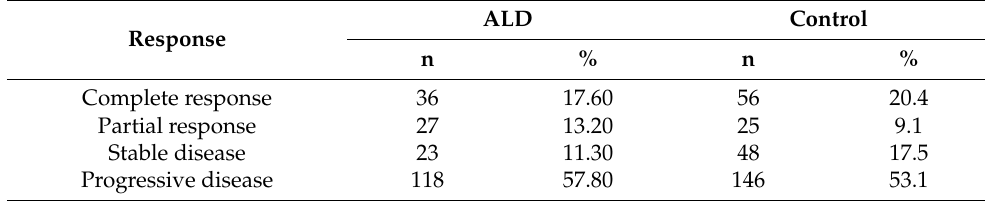
Table 4. Treatment